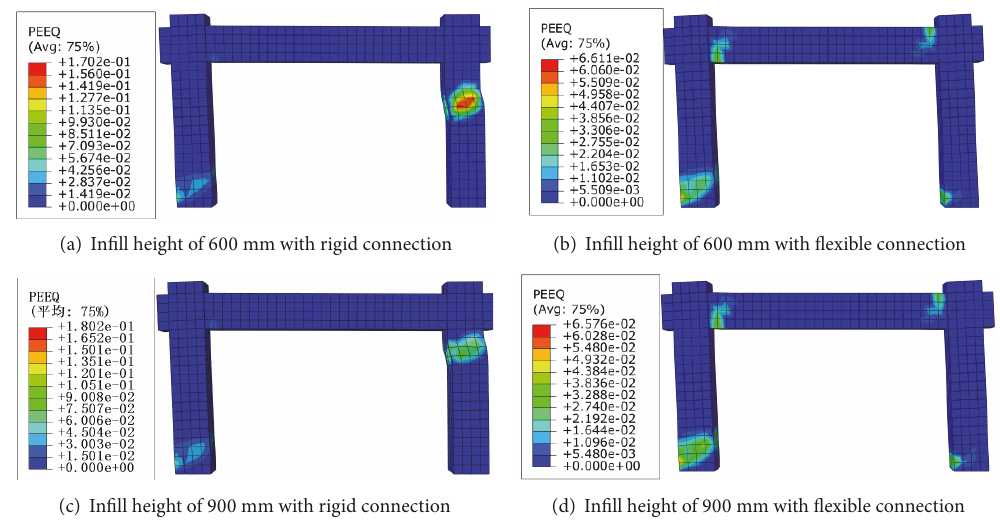
Figure 25: Plastic strain in RC frame with different connection